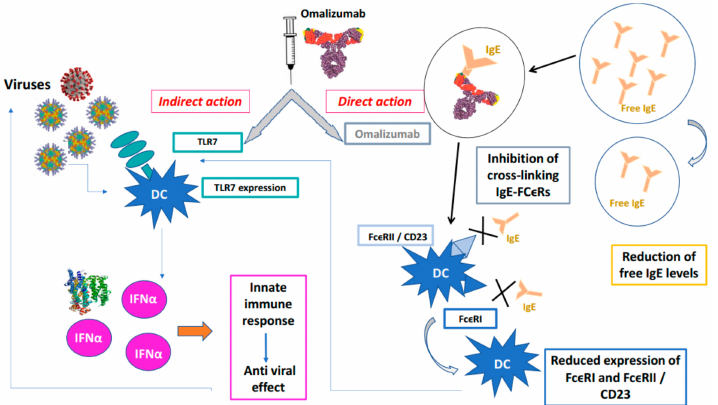
Figure 1. Protective action of omalizumab towards viral infections.Omalizumab acts directly forming IgE / anti-IgE immune complexes that prevent the interaction of IgE with high affinity (Fc (cid:15) RI) and low affinity (Fc (cid:15) RII / CD23) membrane receptors of PD cells, indirectly, PD cells binds viruses by TLCR7 that release INF α and activate innate immune response. X is the blockade of binding on the